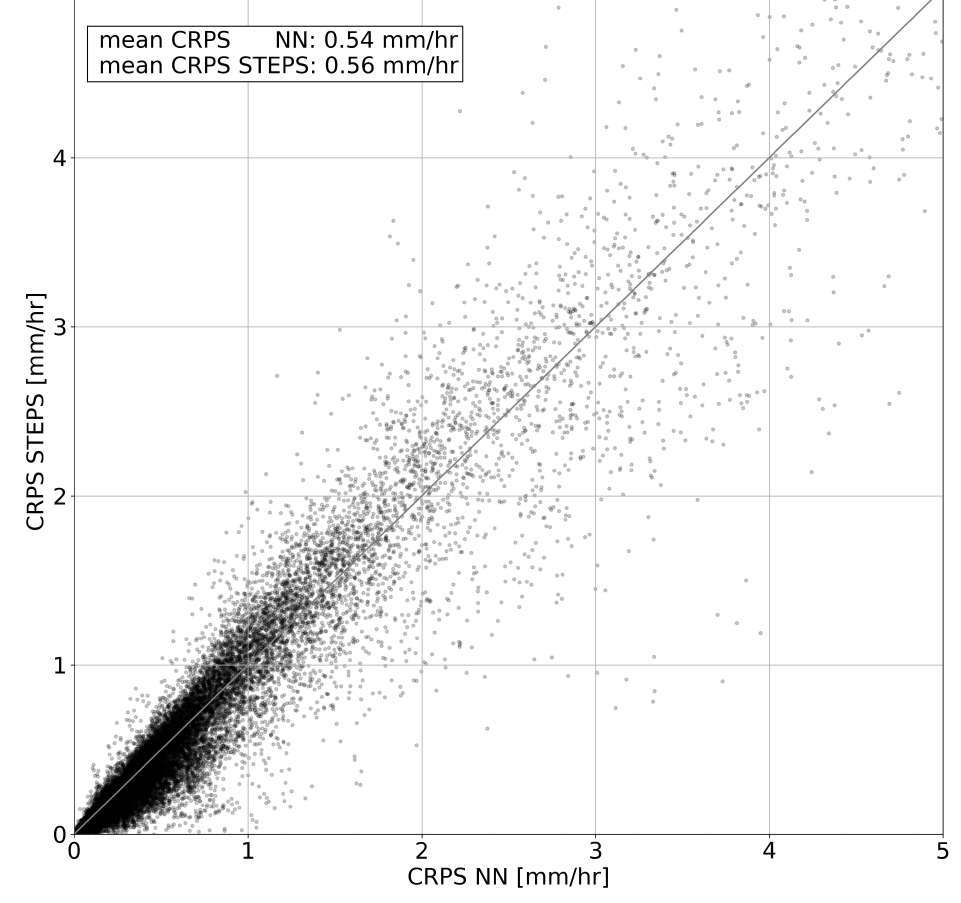
Figure 8. Plot of the STEPS against the NN CRPS for the nowcast of the one hour cumulated rain for all the precipitation events of 2017.